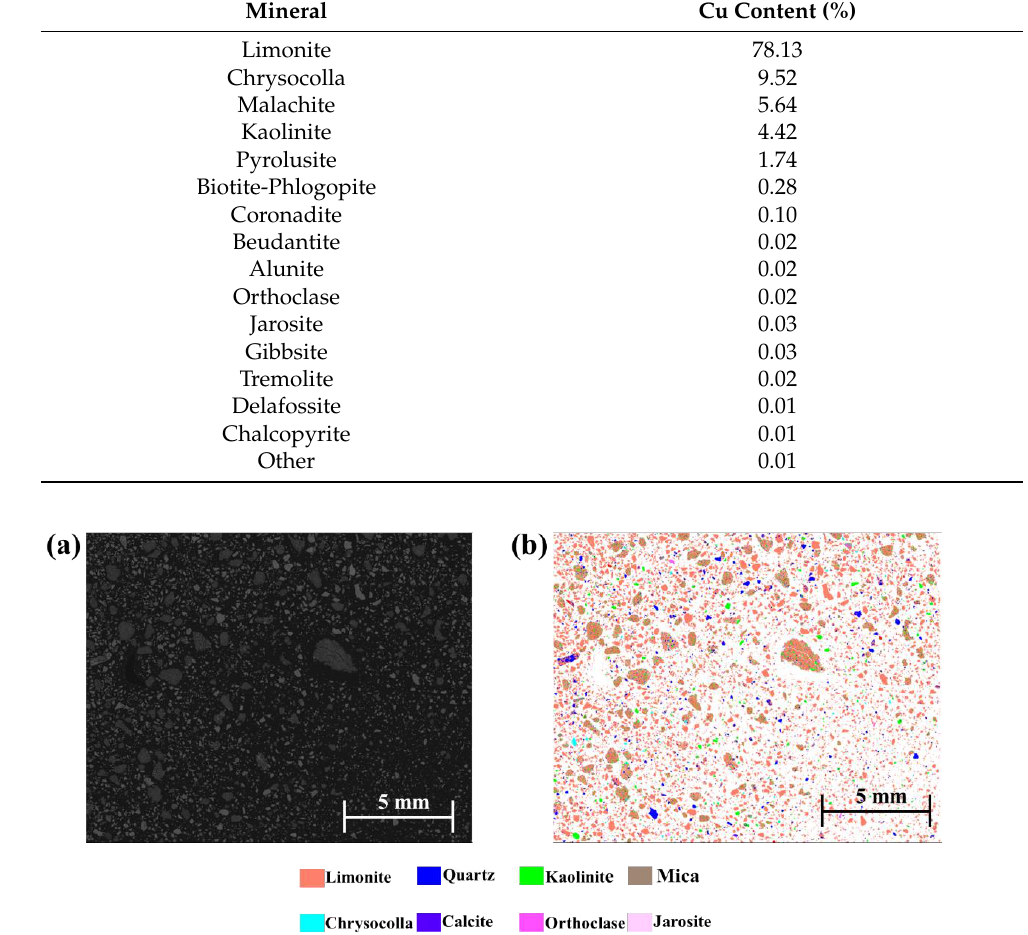
Table 3. The occurrence state of copper element in the COBL ore.